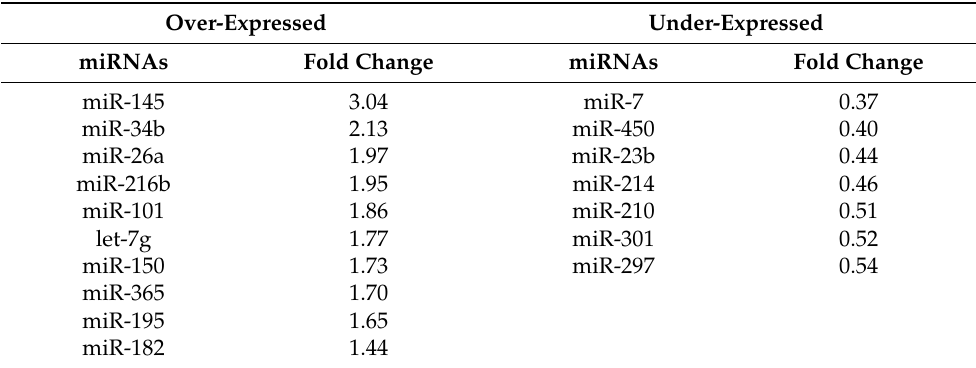
Table 1. Expression of selected miRNAs in 4T1 cells exposed to 60 µ M gallic acid equivalent (GAE) of PEBP for 24 h compared to non-treated cells. Over-Expressed Under-Expressed miRNAs Fold Change miRNAs Fold Change miR-145 3.04